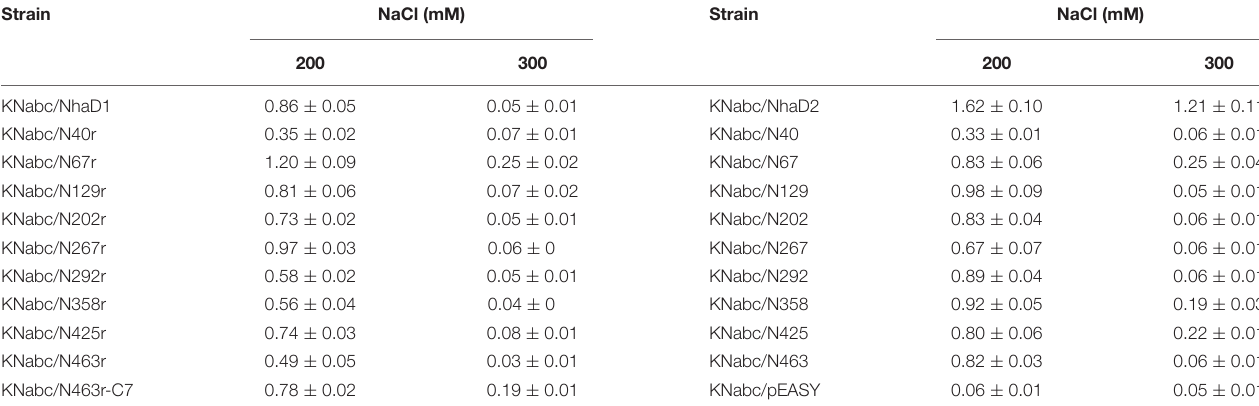
TABLE 2 | Growth of constructed E. coli KNabc chimeras in the LBK medium. Strain